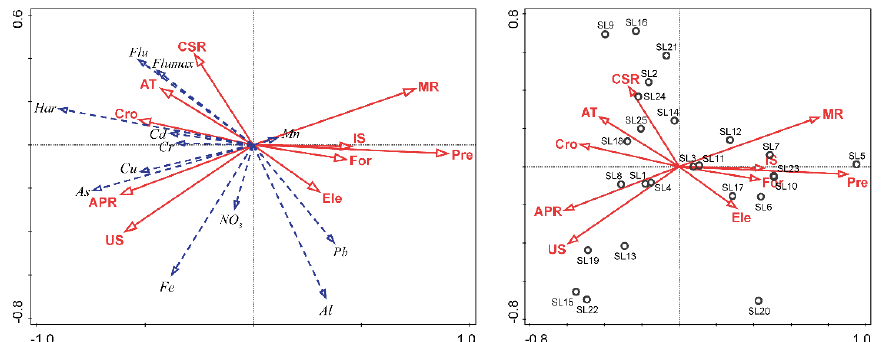
Figure 6. Ordination diagrams showing the relationships between the groundwater quality pa- rameters (represented by blue lines) and the potential influencing factors (represented by red lines) according to the redundancy analysis (RDA). The analyzed potential influencing factors include eleva- tion (Ele), cropland (Cro), forest (For), impervious surface (IS), metamorphic rocks (MR), acid plutonic rocks (APR), unconsolidated sediments (US), carbonate sedimentary rocks (CSR), precipitation (Pre), and air temperature